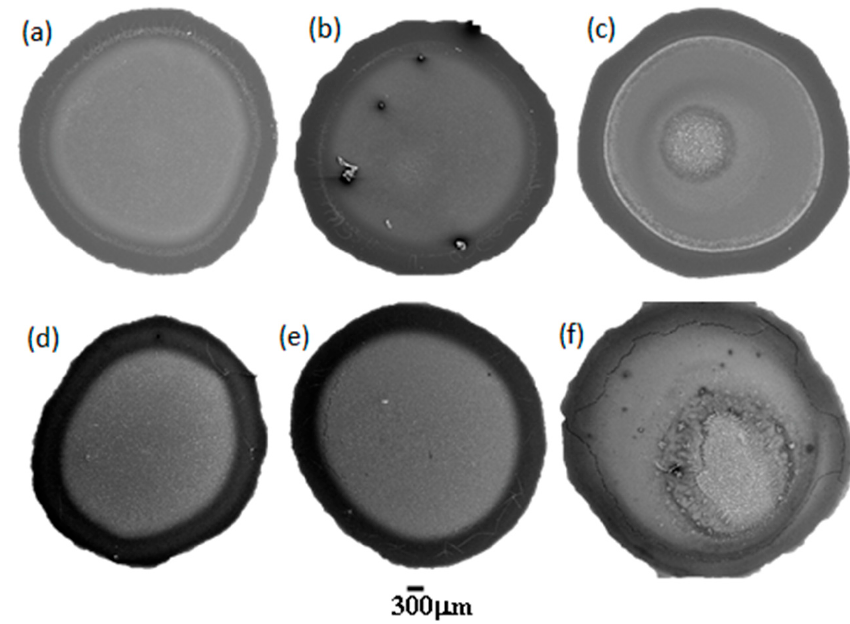
Figure 2. SEM images of dried droplets of PDADMAC–SLES mixtures with SLES concentrations of ( a ) 26 µ M, ( b ) 0.26 mM, and ( c ) 2.6 mM, and of PDADMAC–SLMT mixtures with SLMT concentrations of ( d ) 2.9 µ M, ( e ) 29 µ M, and ( f ) 2.9 mM.